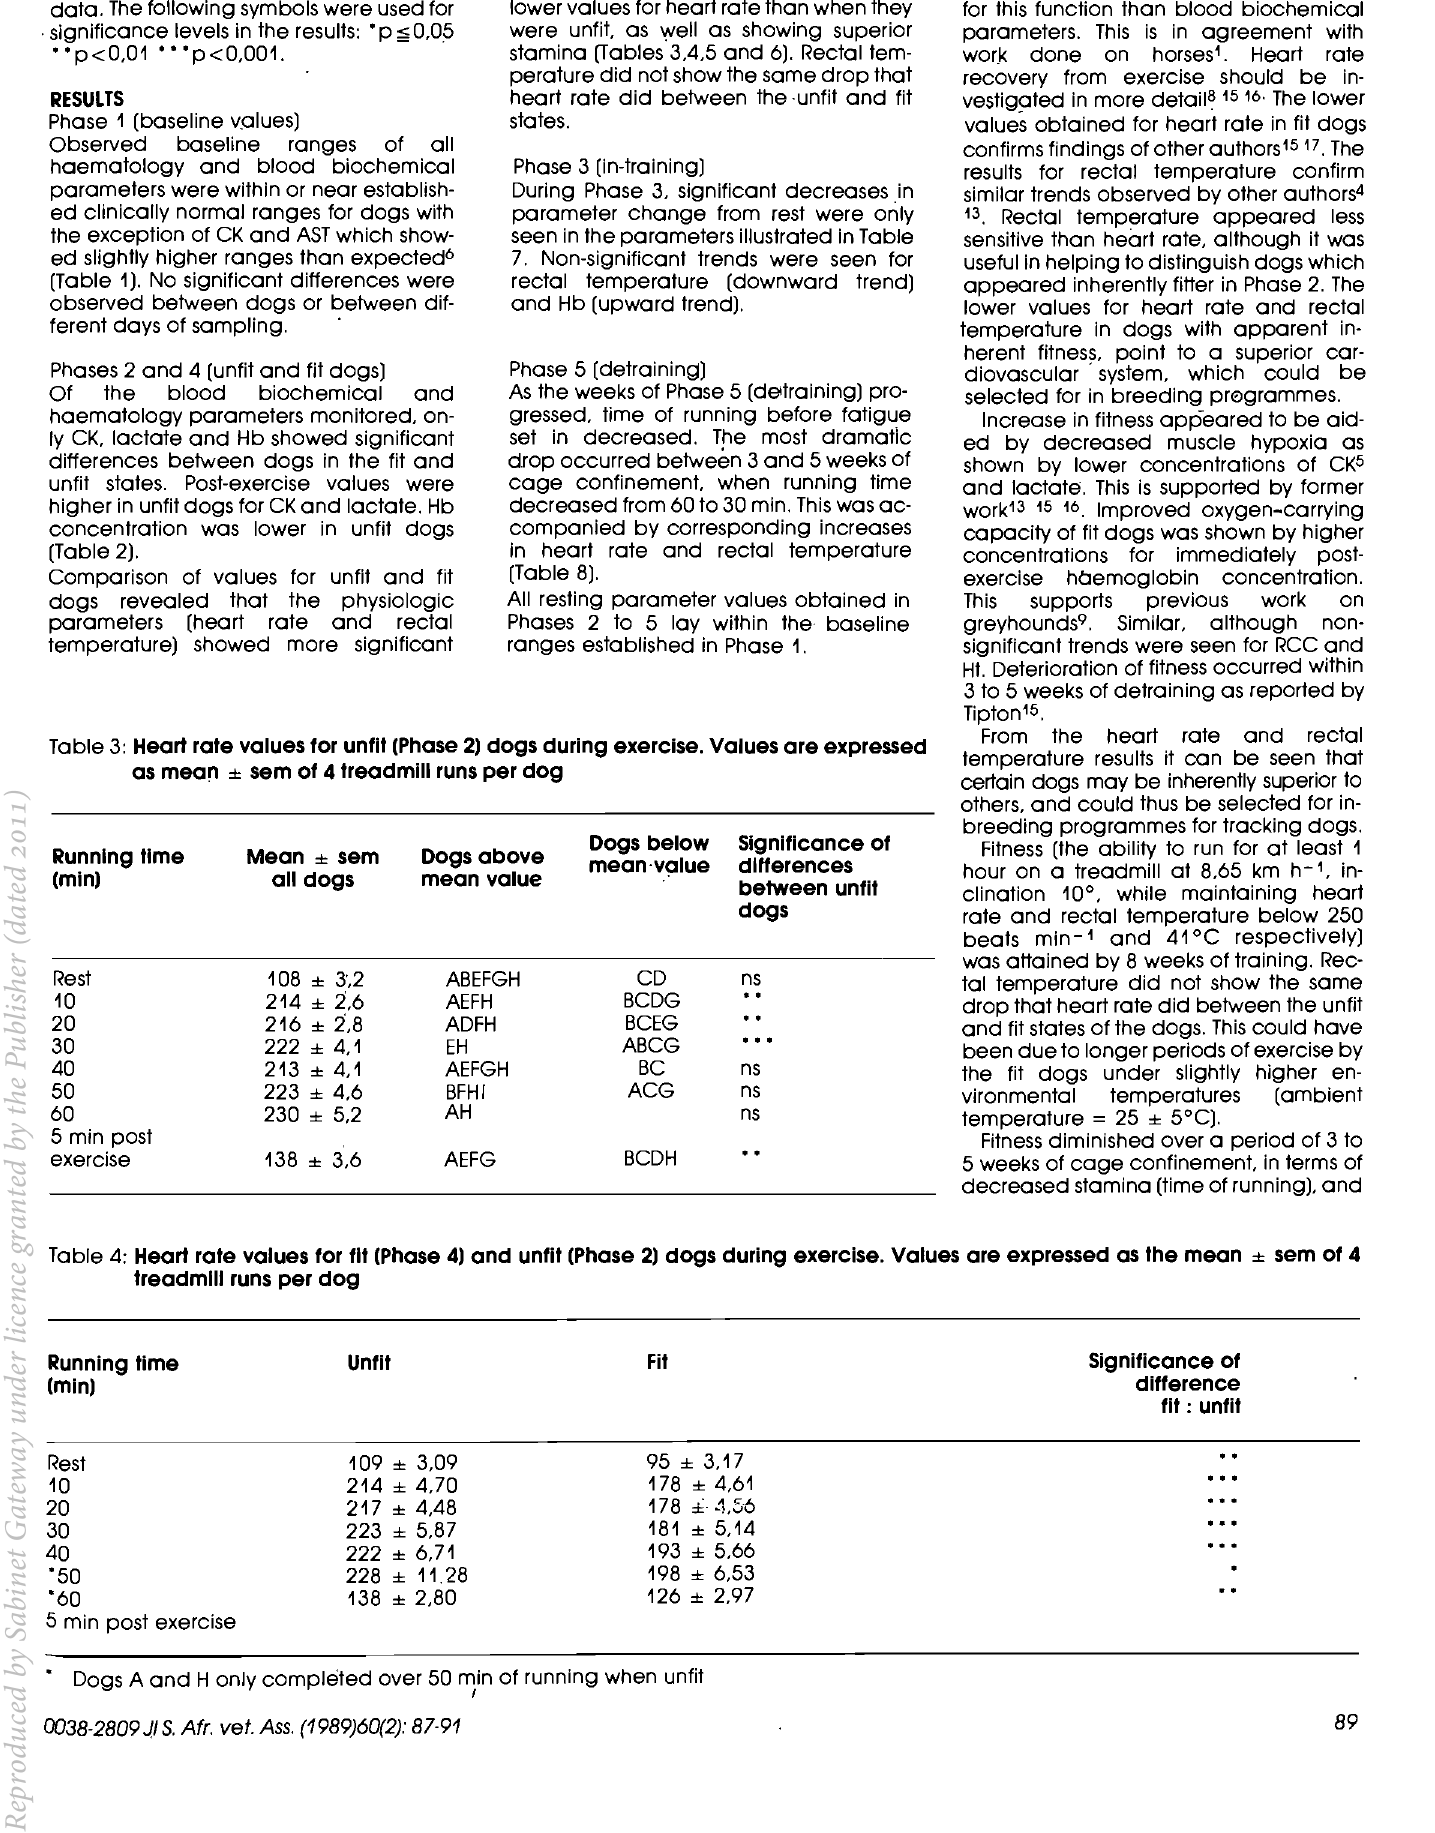
Running time (min)